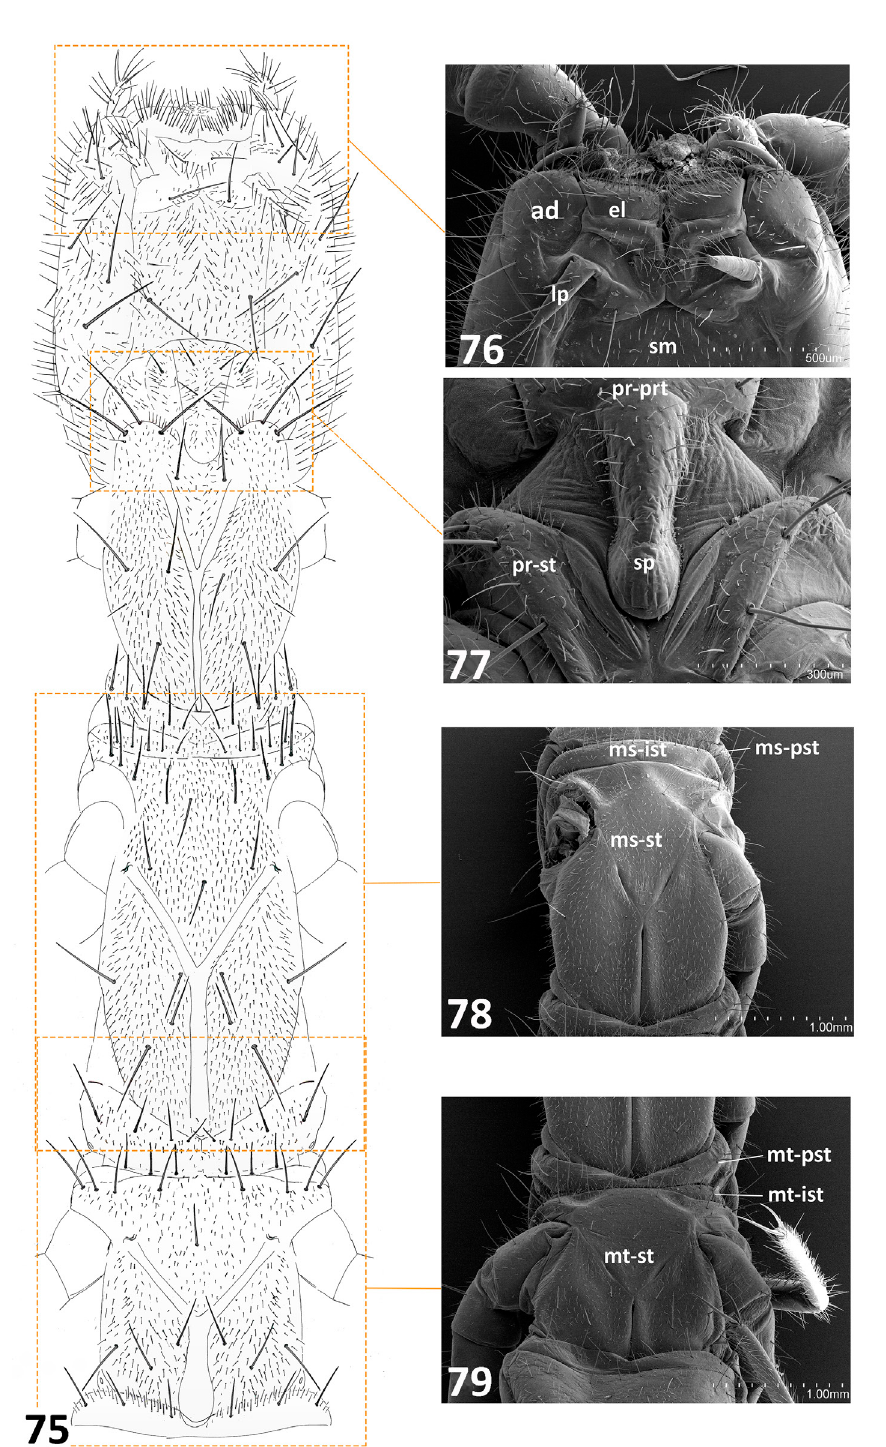
Figs 75‒79. Mueggejapyx brehieri Sendra & Komerički gen. et sp. nov. 75 . Head, prothorax, mesothorax and metathorax, ventral view (paratype, MZB (MCNB) 2020-1157). 76 . Head anterior ventral side, (ad) admentum, (el) external lobule, (lp) labial palp, and (sm) submentum. 77 . Pro-prosternum (pr-prt) with spine (sp) and anterior portion of prosternum (pr-st). 78 . Meso-poststernum (ms-pst), meso-intersternum (ms-ist), and mesosternum (ms-st). 79 . Meta-poststernum (mt-pst), meta-intersternum (mt-ist), and metasternum